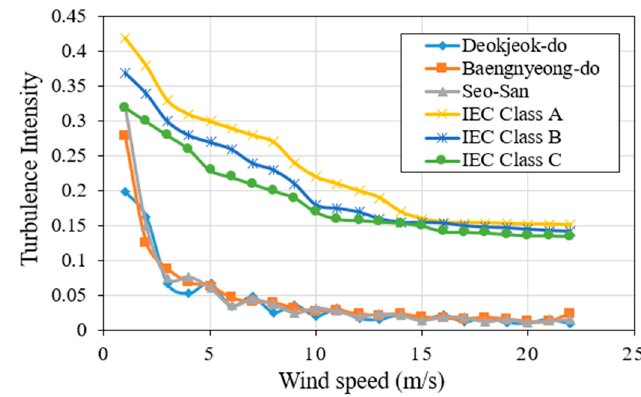
Figure 8. Estimation of TI.